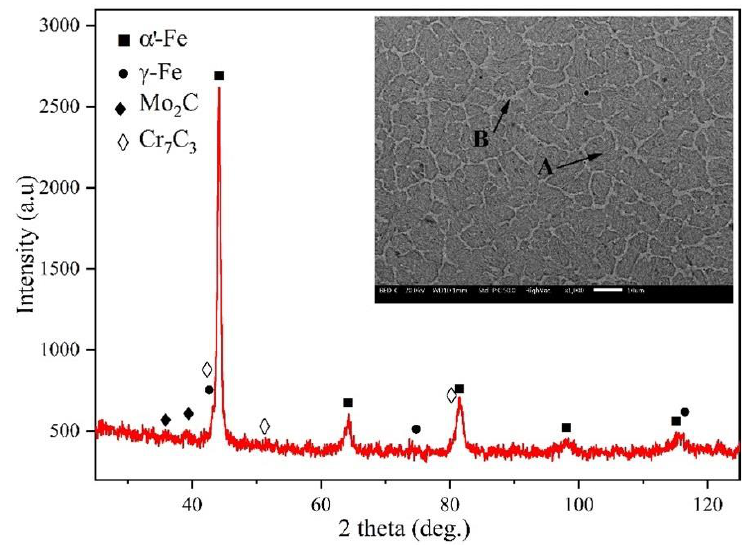
Figure 5. XRD pattern of the disc’s top layer surface. Inset: SEM image of the top layer, showing the microstructure of the analyzed surface, with the indication of the points “A” and “B”, where EDXS analyses were carried out to evaluate the local composition (see Table 3).